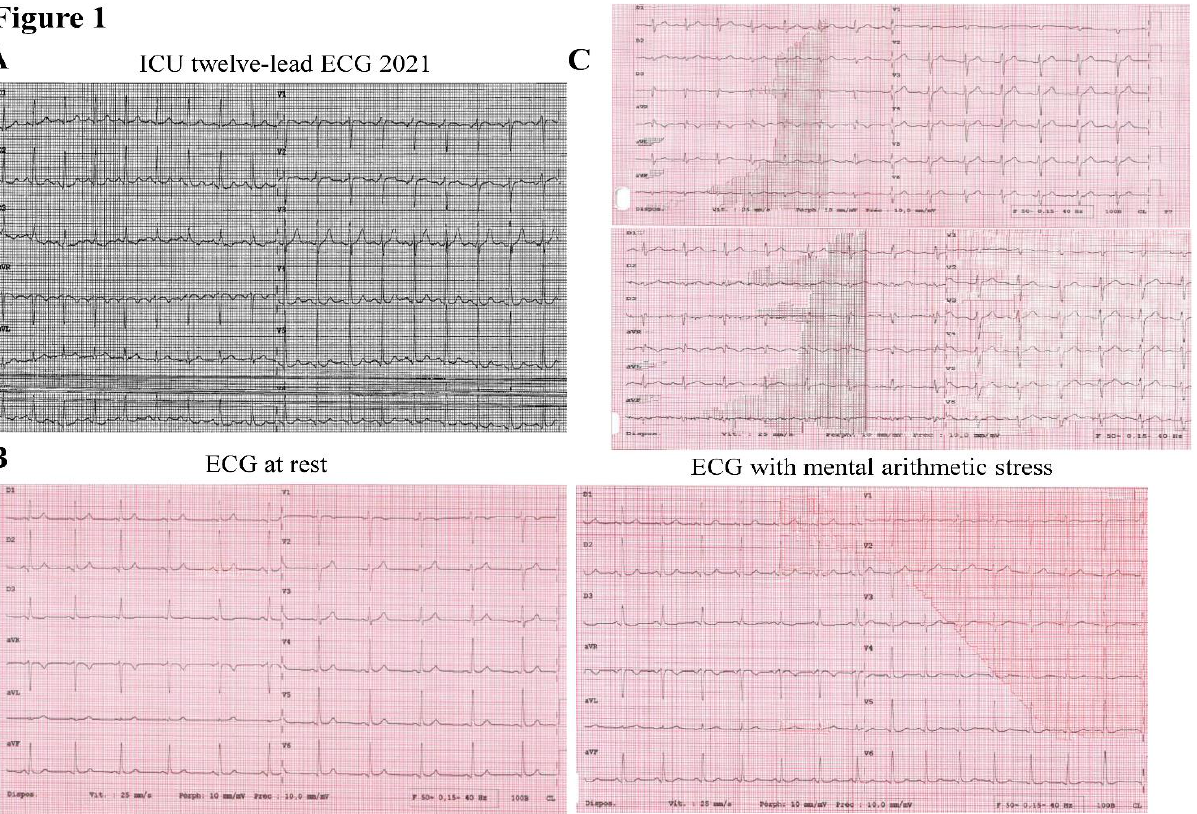
Figure 1. ( A ). ICU twelve-lead ECG showed a normal sinus rhythm, a normal PR interval at 160 milliseconds, a QRS complex, and a silent “prolonged” QTc interval of 436 milliseconds. ( B ). Re- peated resting (left panel) and mental arithmetic stress ECG (right panel) showed QTc intervals of 400 and 457 milliseconds, respectively, which confirm the diagnosis of LQTS. ( C ) . His father’s ECG at rest and during mental arithmetic stress showed a prolonged QTc of 460 (upper panel) and 485 milliseconds (lower